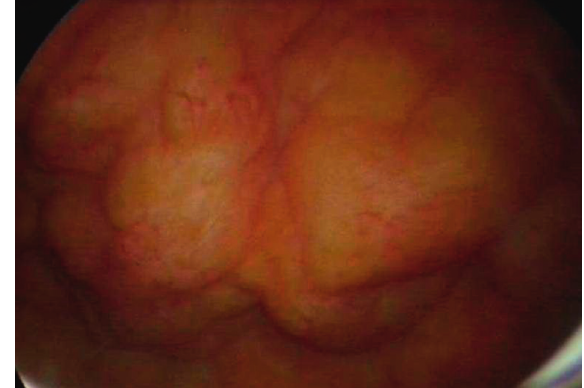
Figure 2: Cystoscopy showed multifocal yellowish bladder